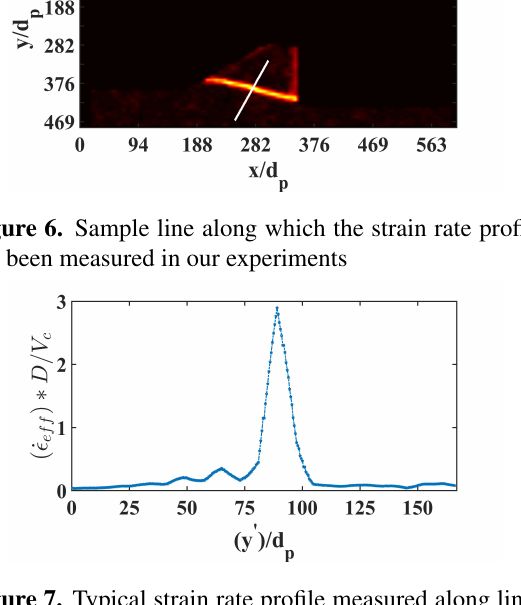
Figure 7. Typical strain rate profile measured along lines perpendicular to the shear band